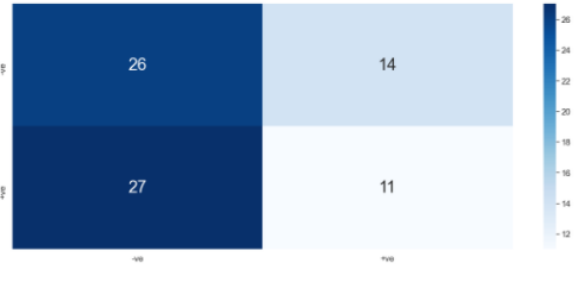
Figure 21. Performance of LR